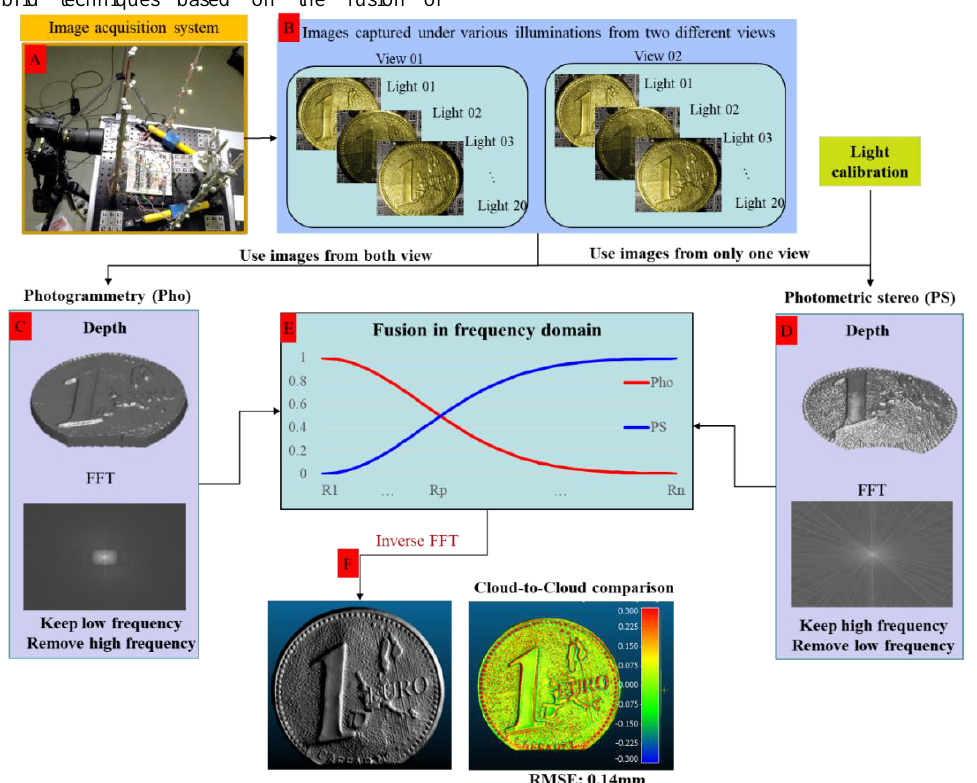
Figure 2. General steps - presented in Section 3 - to fuse photogrammetry and PS data using FFT filter. A) acquire the images, B) generate depth using both photogrammetry and PS, C) transfer them to the FFT domain, D) Filter low frequency from